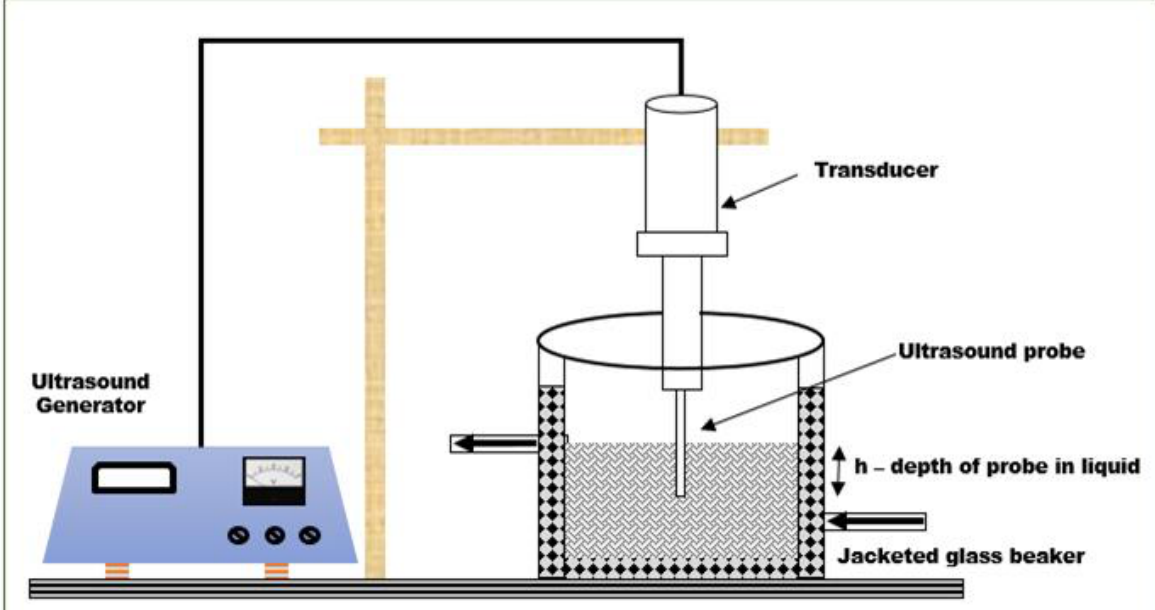
Figure 4. Illustrative diagram of ultrasound-assisted extraction